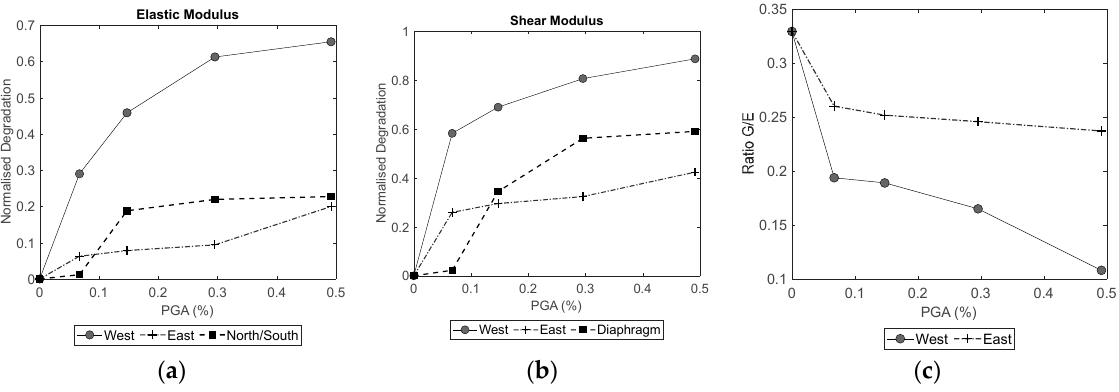
Figure 9. Degradation of ( a ) elastic and ( b ) shear moduli Equation (17) and ( c ) their ratio between subsequent phases from FE calibration.